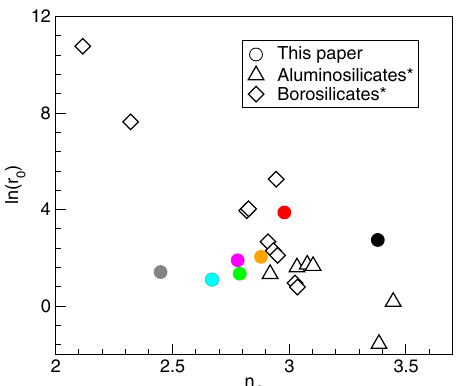
Fig. 10 Silicon-based ln ( r 0 ) for different glasses as a function of n c , averaged on all elements. n c is here calculated based on work performed by Gin et al. 53 with asterisks (*) near the glasses type in the legend denoting data obtained in similar conditions from said paper. Colors attributed to each point corresponds to each glass as used in Fig.